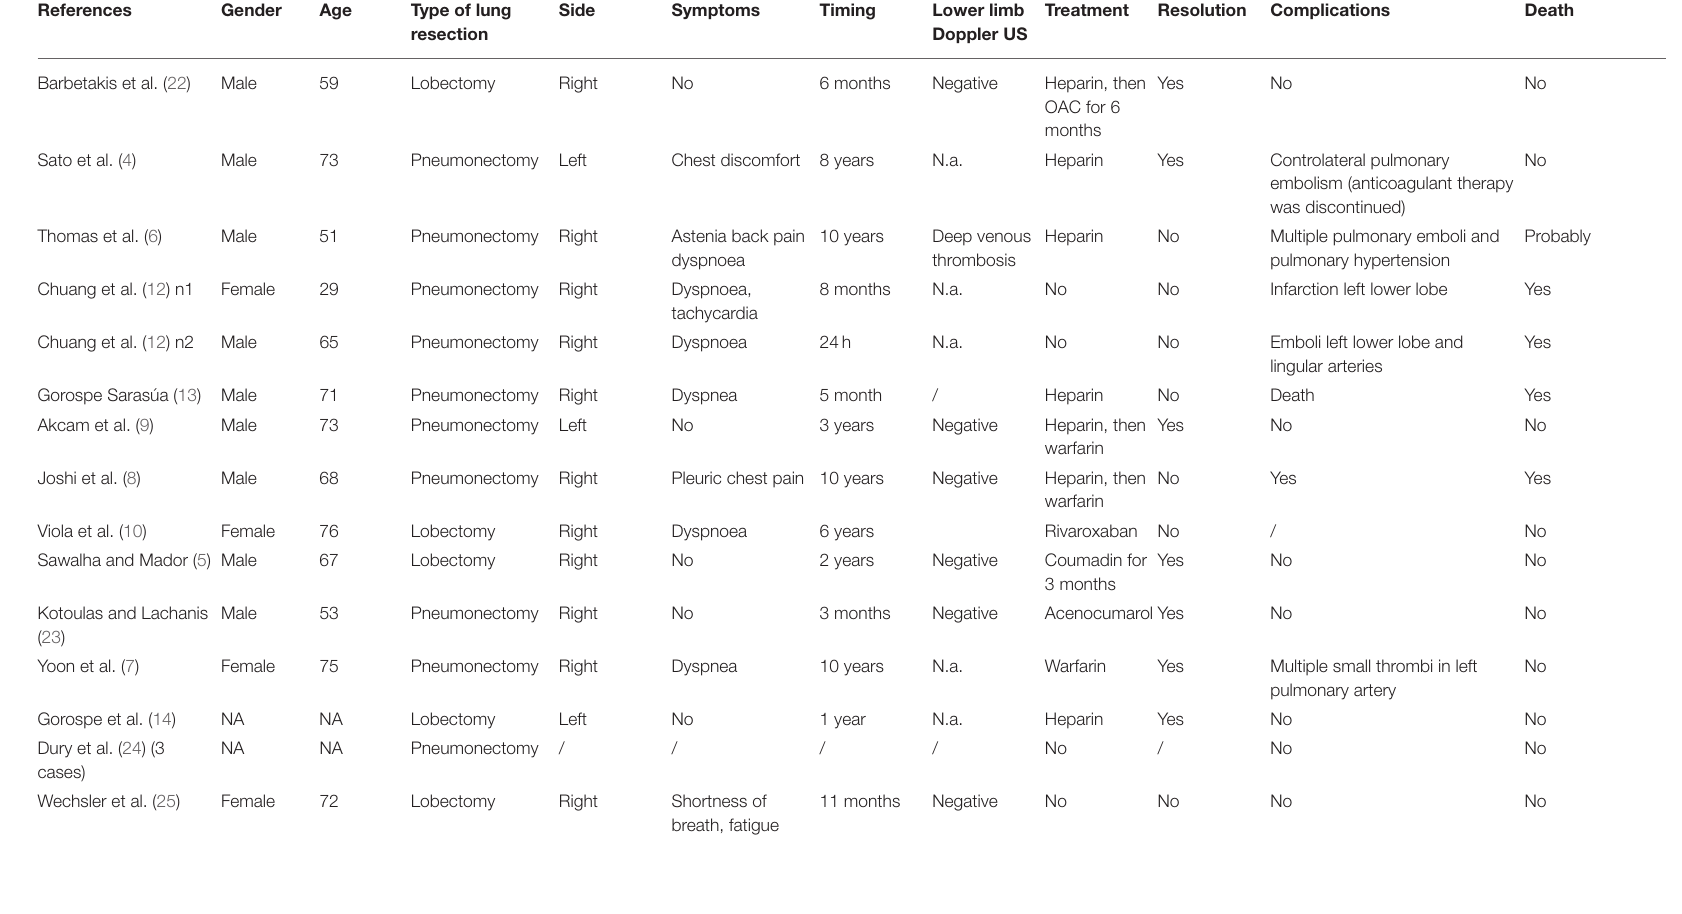
TABLE 1 | Cases of PAST reported in the English